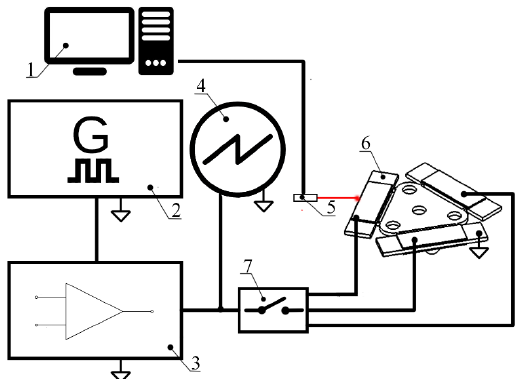
Figure 15. Scheme of the experimental setup: 1—a computer with data acquisition and switch control software; 2—function generator; 3—power amplifier; 4—oscilloscope; 5—displacement sensor; 6—a prototype of the actuator; 7—digitally controlled switch box.